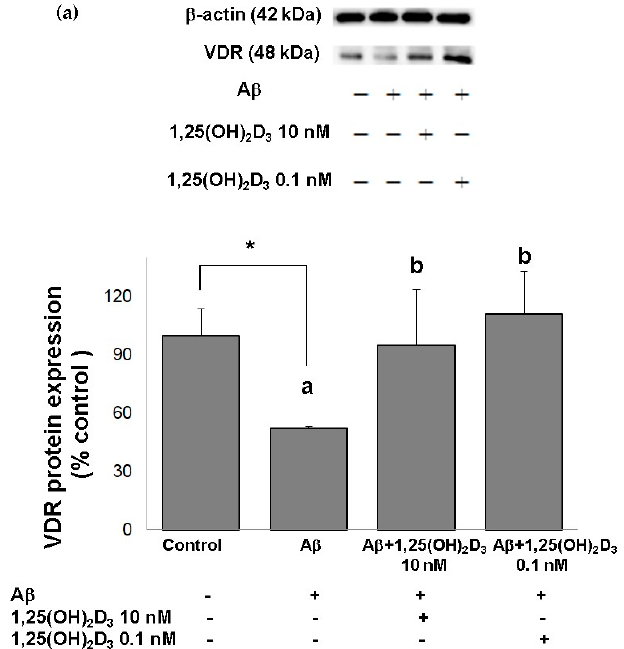
Student’s t test). Bars of A β , A β + 0.1 nM 1,25(OH) 2 D 3 , and A β + 10 nM 1,25(OH) 2 D 3 with di ff erent